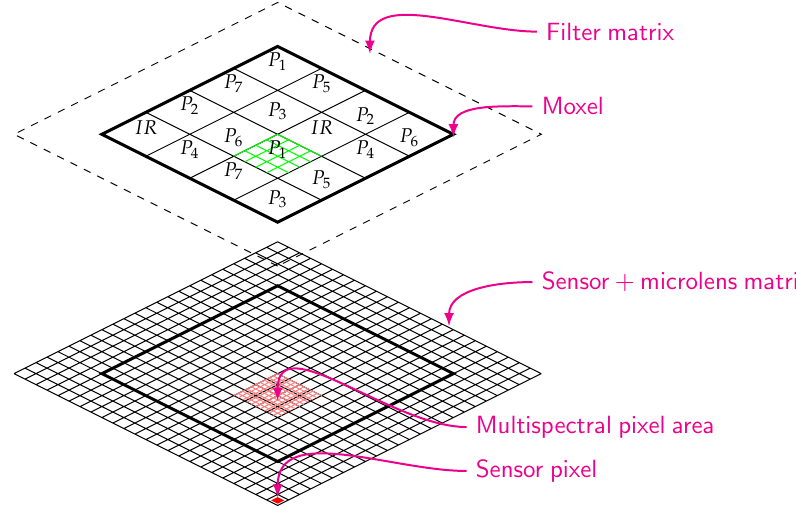
Figure 2. The mosaic arrangement is a moxel assembly over a monochrome sensor. The sensor matrix is composed of photodiodes and a microlens array. Each channel filter covers 4 × 4 sensor pixels.